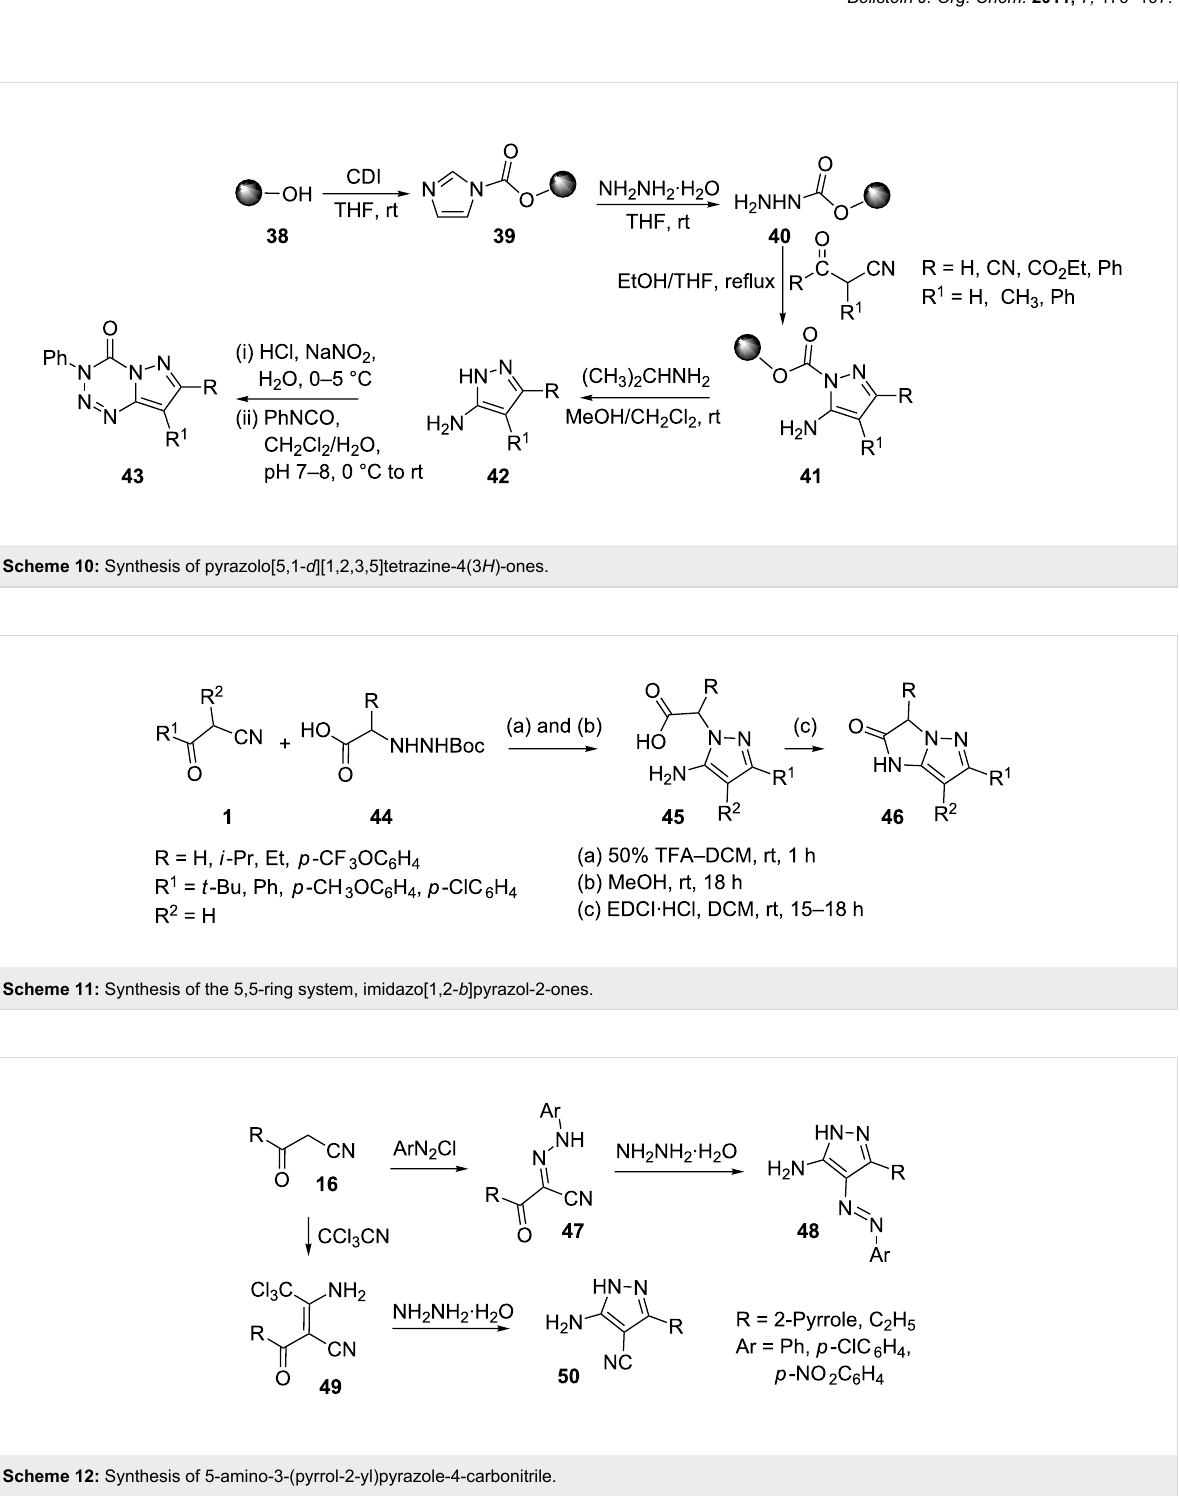
Synthesis of 5-amino-3-aryl-1 H -pyrazoles 53 has been reported using benzoylacetonitrile 51 as starting material. Substituted phenylhydrazines on reaction with substituted 1-aminocinna- monitriles 52 , obtained from base catalyzed reaction of benzo- ylacetonitrile 51 and acetonitrile, yielded 5-amino-3-aryl-1 H - pyrazoles 53 . Corresponding amide derivatives, i.e., N